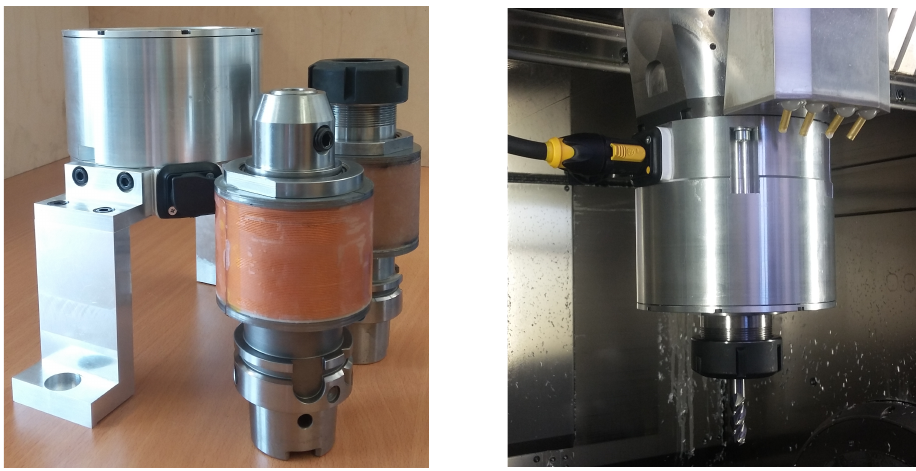
Figure A2. Photos of the experimental setup, showing primary and secondary parts separately and mounted together on a CNC milling